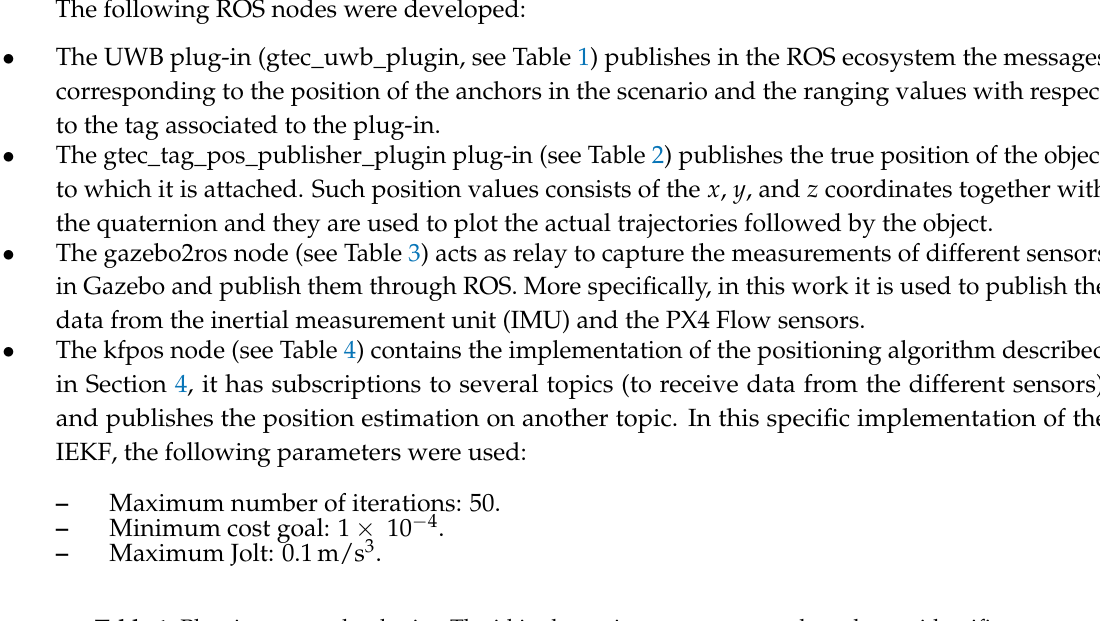
Table 1. Plug-in gtec_uwb_plugin . The id in the topic route corresponds to the tag identifier.